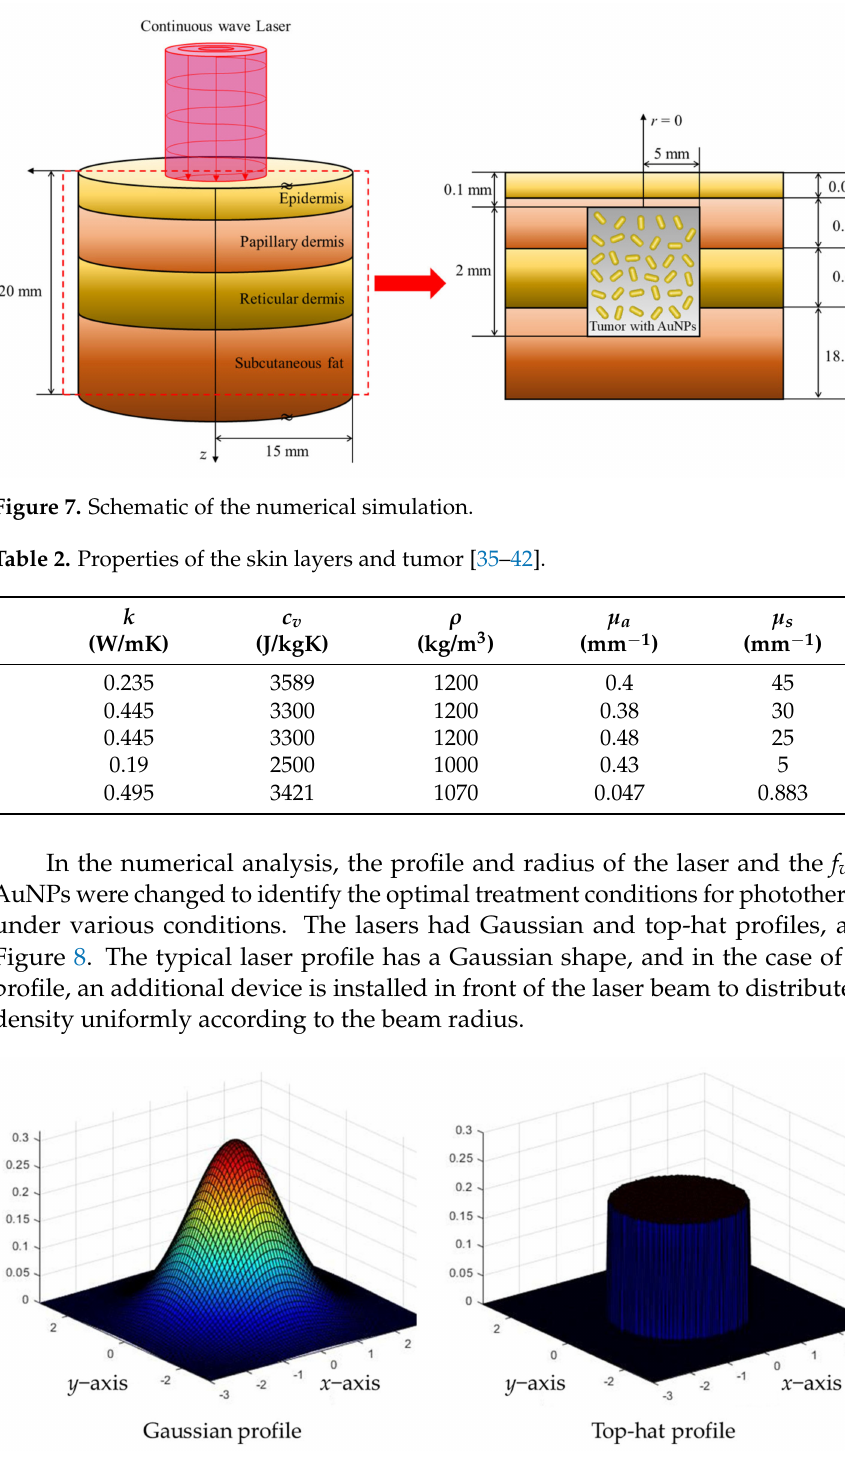
Figure 8. Schematic of laser